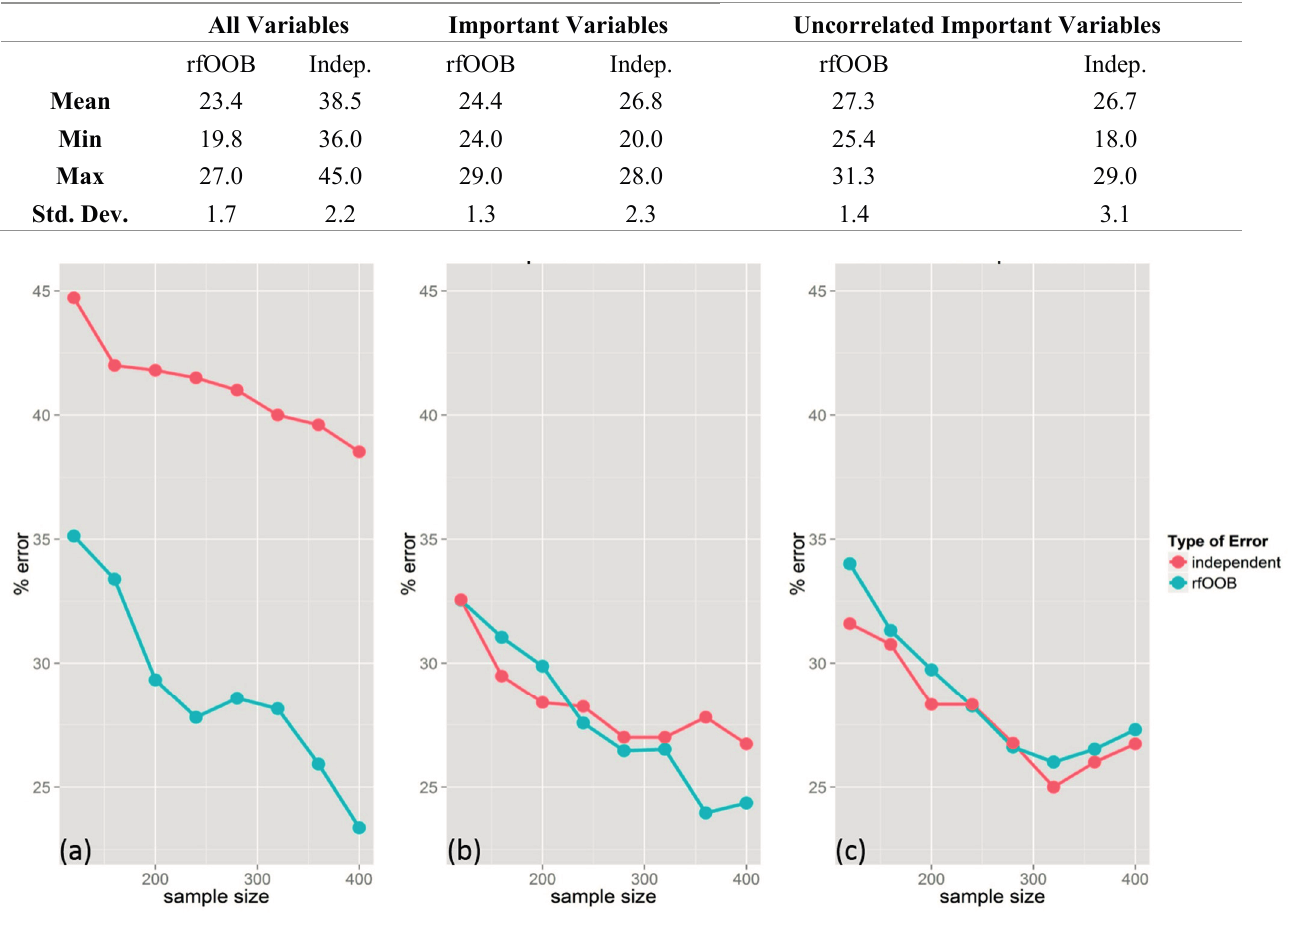
Figure 8. Mean of rfOOB and independently assessed error for 25 iterative classifications varying the sample size with All Variables ( a ), Important Variables ( b ), and Uncorrelated Important Variables ( c